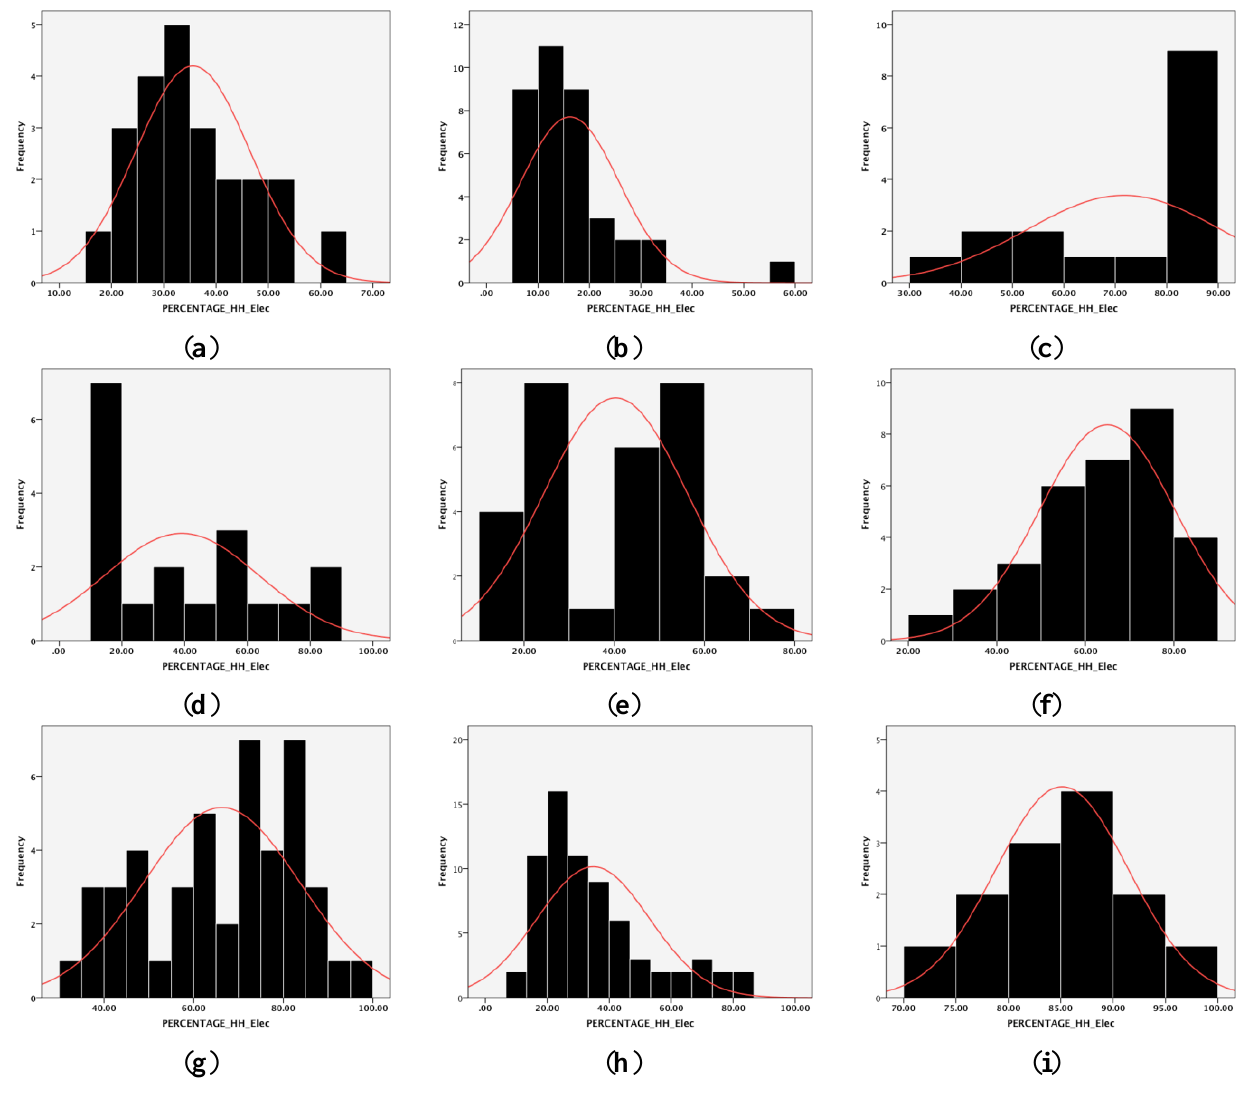
Figure 1. Level of electrification in nine states of India: ( a ) Assam; ( b ) Bihar; ( c ) Chhattisgarh; ( d ) Jharkhand; ( e ) Odisha; ( f ) Rajasthan; ( g ) Madhya Pradesh; ( h ) Uttar Pradesh; ( i )